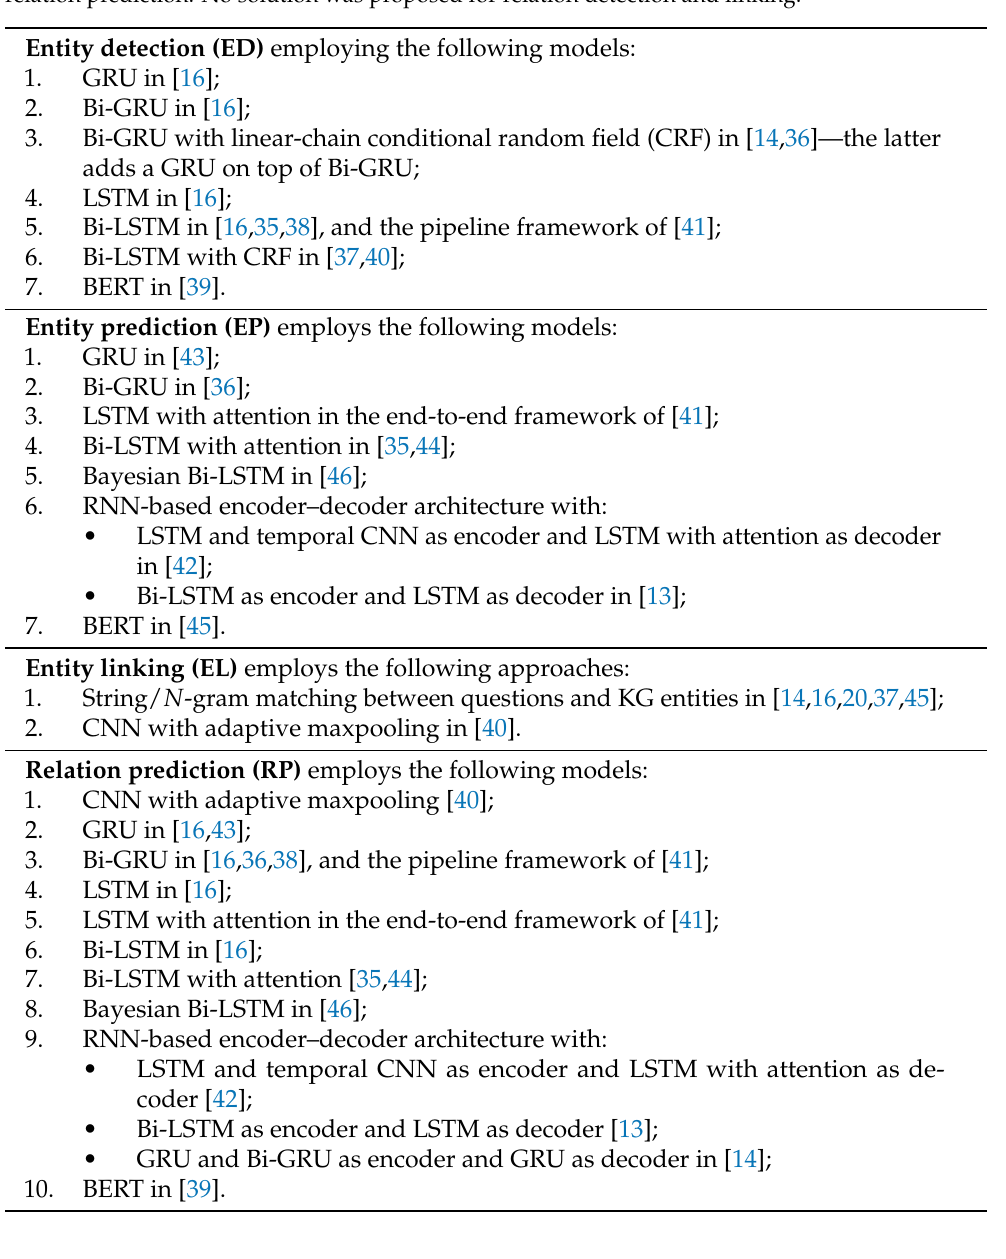
Table 2. Models/approaches employed for entity detection, prediction, and linking, as well as relation prediction. No solution was proposed for relation detection and